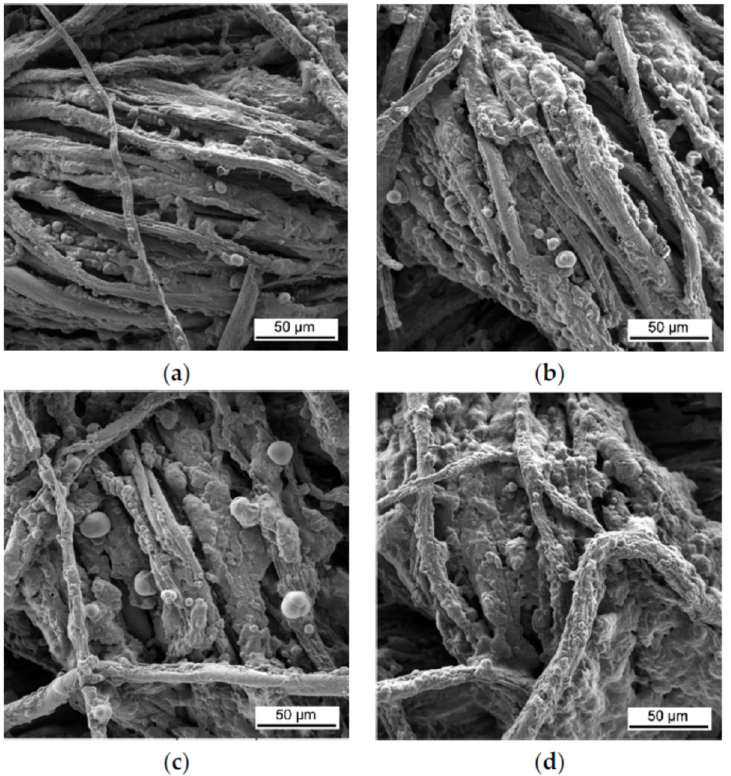
Figure 3. SEM images of the char of cotton samples treated with ( a ) 8, ( b ) 10, ( c ) 12 and ( d ) 15 BLs of PA/CH-U after performing vertical flame testing [92].